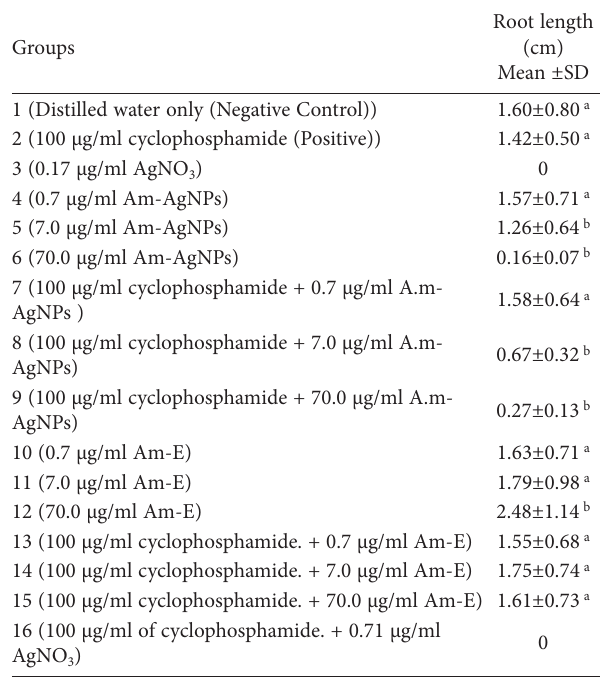
Table 3. Effects of Aqueous leaf Extract of A. muricata and its fabri- cated silver nanoparticles on A. cepa root